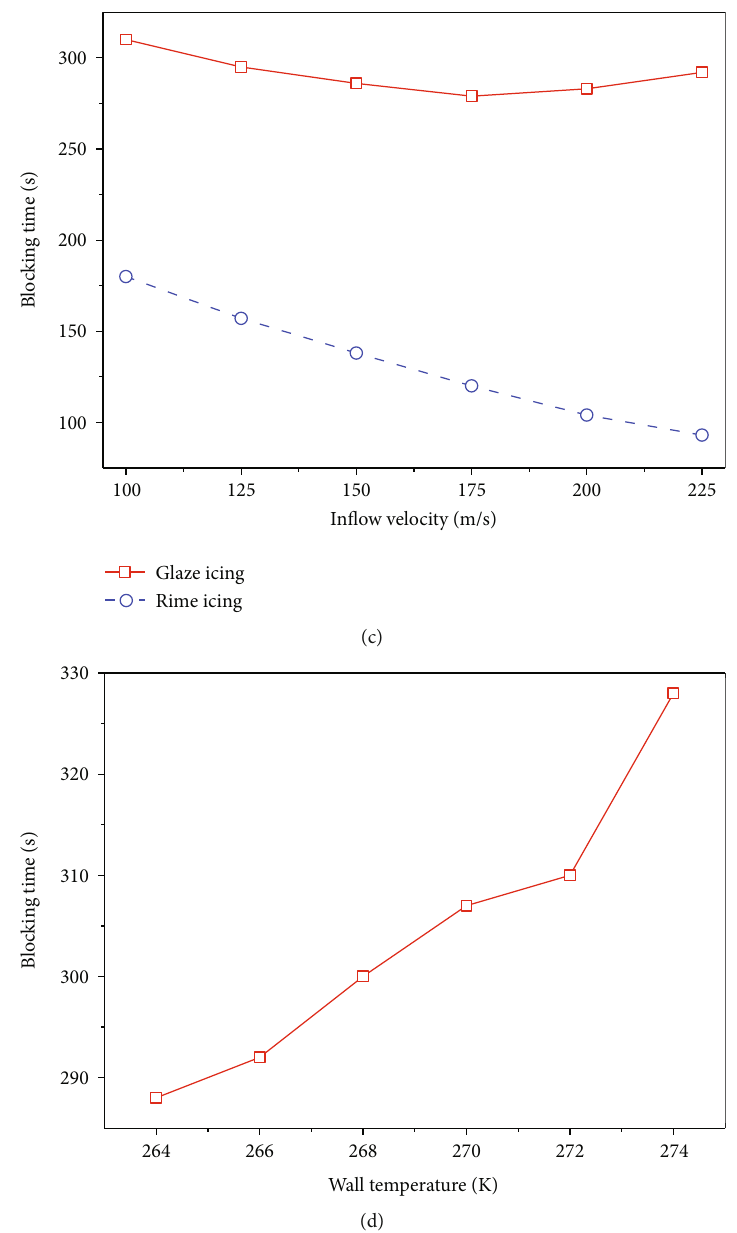
Figure 16: Failure time due to ice accretion under (a) di ff erent AoAs, (b) di ff erent in fl ow temperatures, (c) di ff erent in fl ow velocities, and (d) di ff erent pitot tube wall